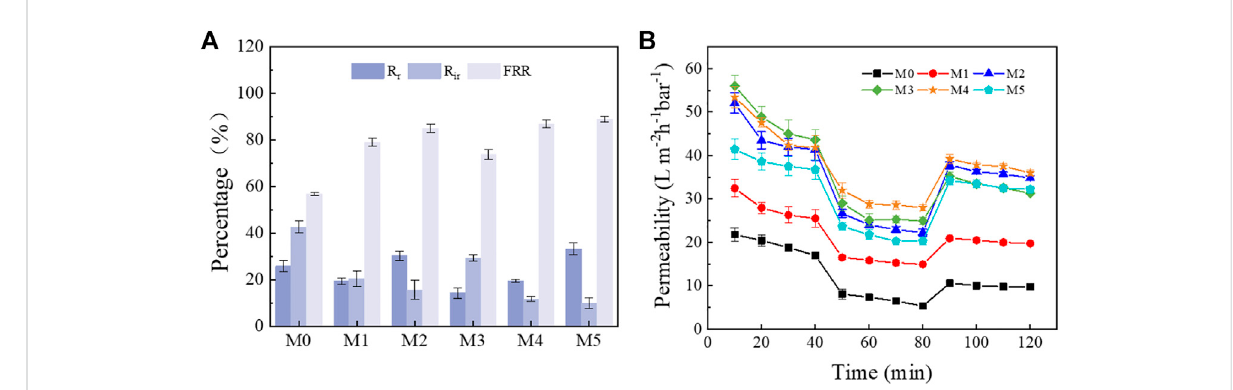
FIGURE 9 Anti-fouling performance: (A) water fl ux recovery and fouling resistance ratio of membranes; (B) Time-dependent fl ux of membranes for BSA solution fi ltration.